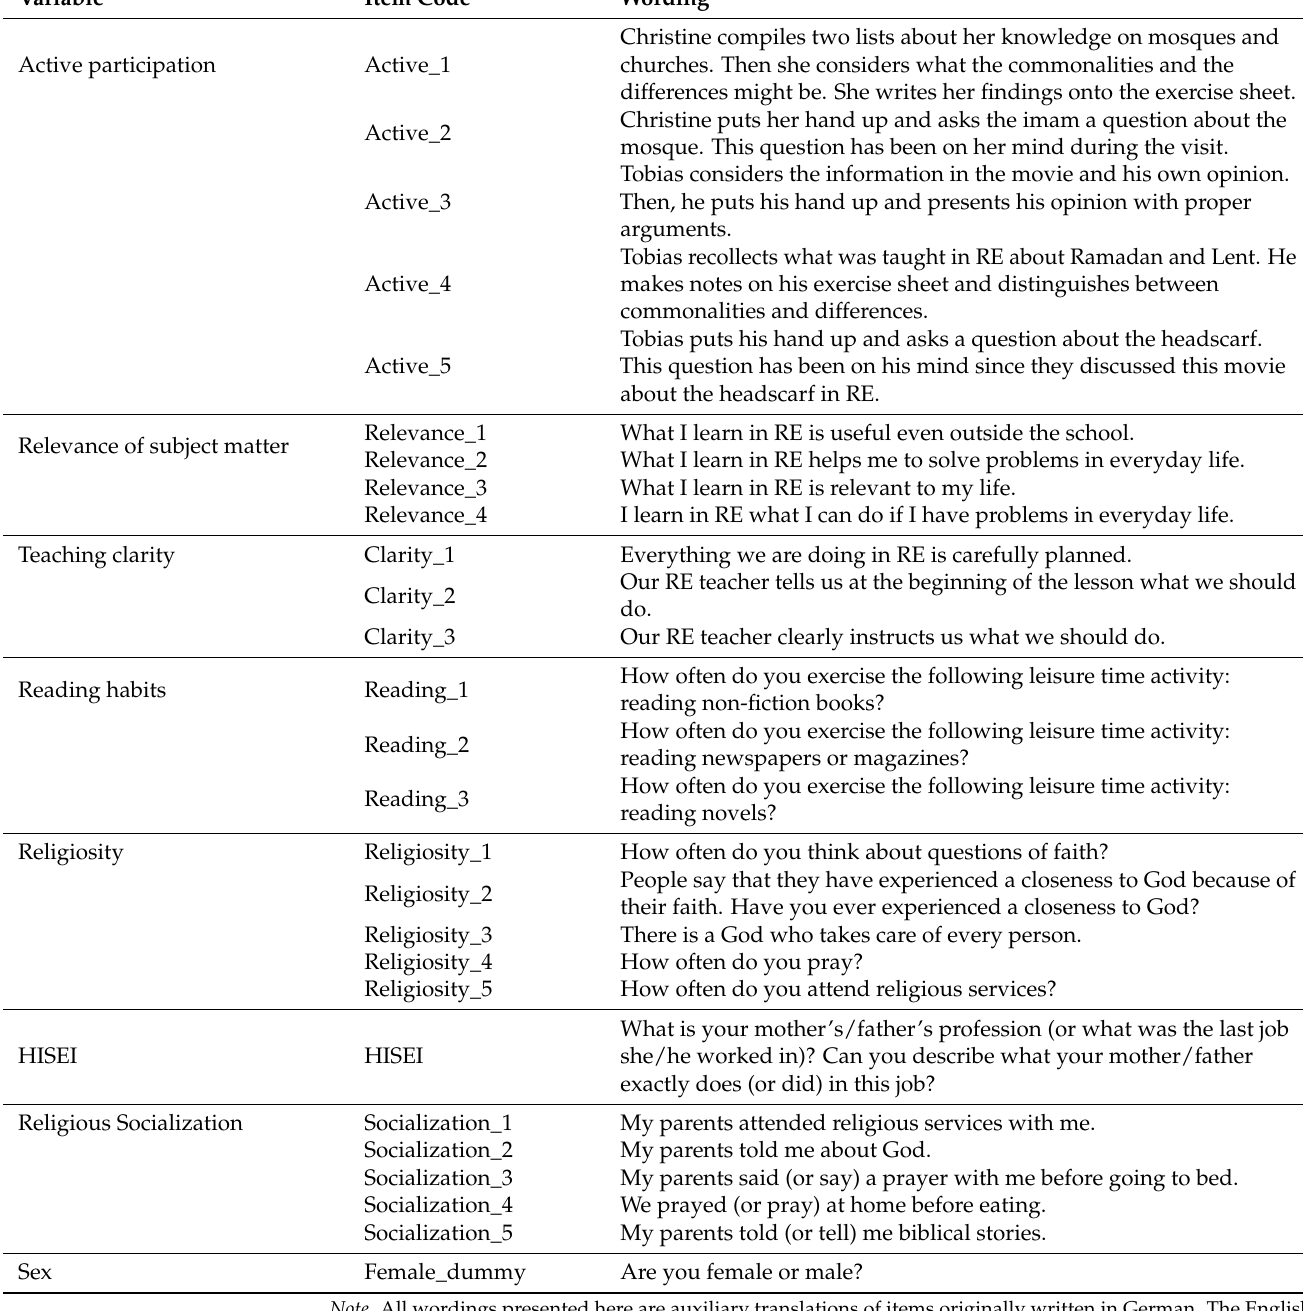
Table A1. Documentation of the item